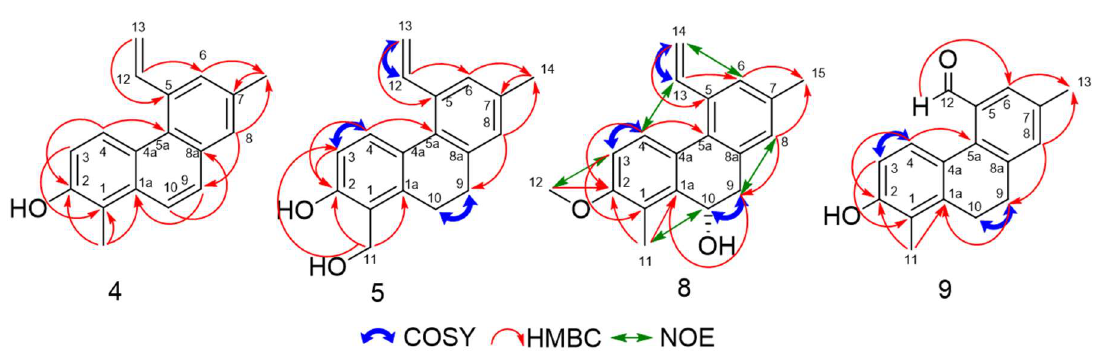
Figure 3. Key COSY, HMBC and NOESY correlations for compounds 4 , 5 , 8 and 9 .